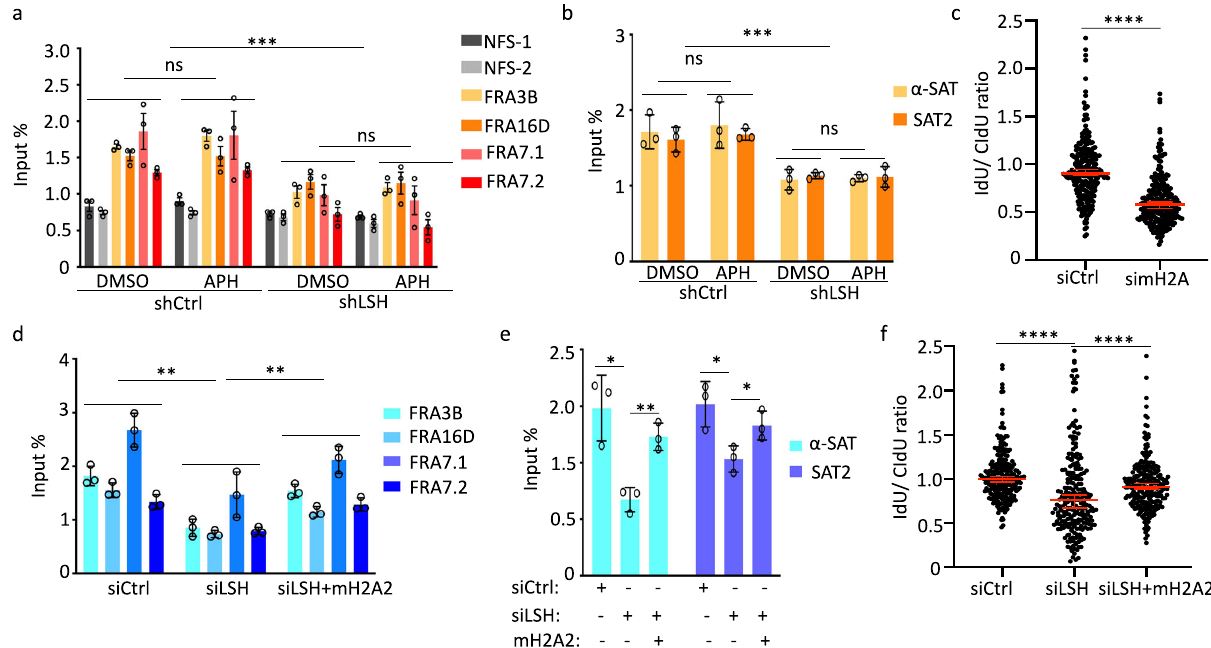
Fig. 3 MacroH2A de fi ciency phenocopies LSH de fi ciency. a ChIP-qPCR analysis for detection of macroH2A1 enrichment at common fragile sites (FRA3B, FRA16D, FRA7.1, and FRA7.2) and control sites (NFS-1, NFS-2) in mock-treated (DMSO) or aphidicolin-treated (APH) U2OS cells transfected with LSH shRNA (shLSH) or control shRNA (shCtrl). Data are represented as mean ± SD ( n = 3 independent experiments). ns = not signi fi cant, *** p < 0.001 by Student ’ s two-tailed t test. b ChIP-qPCR analysis for detection of macroH2A1 enrichment at satellite sequences ( α -SAT and SAT-2) in mock-treated (DMSO) or aphidicolin-treated (APH) U2OS cells transfected with shLSH or shCtrl. Data are represented as mean ± SD ( n = 3 independent experiments). ns = not signi fi cant, *** p < 0.001 by Student ’ s two-tailed t test. c Nascent DNA degradation analysis in U2OS cells transfected with the indicated siRNA. The IdU/CldU ratio calculations are done as outlined for Fig. 2a. Representative of n = 3 independent experiments. Data are represented as median ± 95% CI ( n = 250 DNA fi bers). **** p < 0.0001 by two-tailed Mann – Whitney test. d ChIP-qPCR analysis for mH2A2 enrichment at CFSs in untreated U2OS cells transfected with the indicated siRNA (siCtrl or siLSH) and with macroH2A2 expressing construct (mH2A2 + siLSH). Data are represented as mean ±